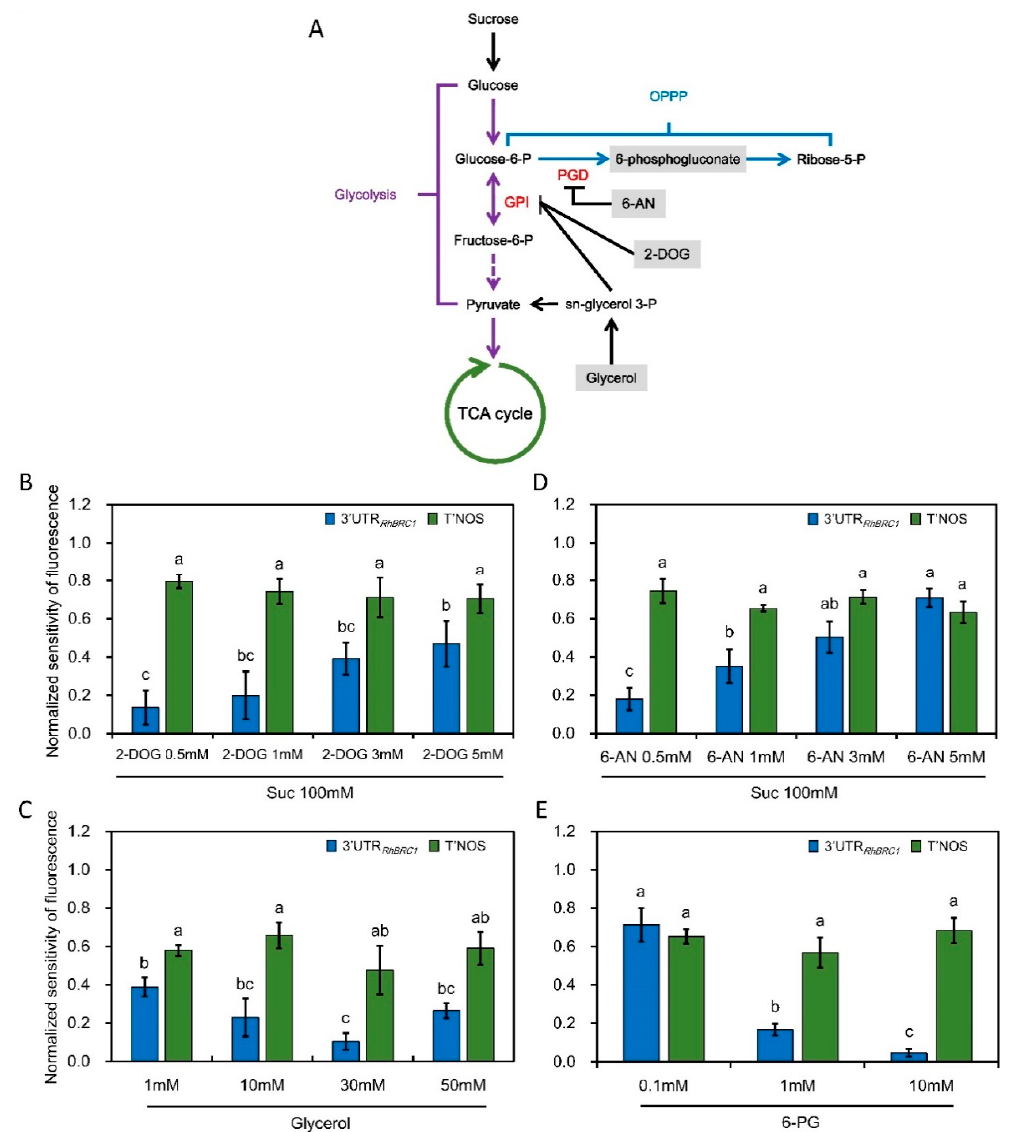
Figure 3. Both glycolysis / the TCA-cycle and the OPPP participate in the posttranscriptional regulation of RhBRC1 through its 3 ′ UTR. ( A ) Different effectors function at the level of different enzymes in the primary metabolism; ( B , D ) fluorescence levels of 3 ′ UTR RhBRC1 - and T’NOS-transformed calluses in response to 100 mM sucrose and different 2-DOG or 6-AN concentrations, respectively; ( C , E ) fluorescence levels of 3 ′ UTR RhBRC1 - and T’NOS-transformed calluses in response to different glycerol or 6-AN concentrations, respectively. GPI, glucose-6-phosphate isomerase; GPD, glucose-6-phosphate dehydrogenase; 6-PG, 6-phosphogluconate, Suc, sucrose. Data are means ± SEs of three measurements, and each measurement was performed on six Rosa calluses. The letters indicate significant differences between the different treatments with p < 0.05.